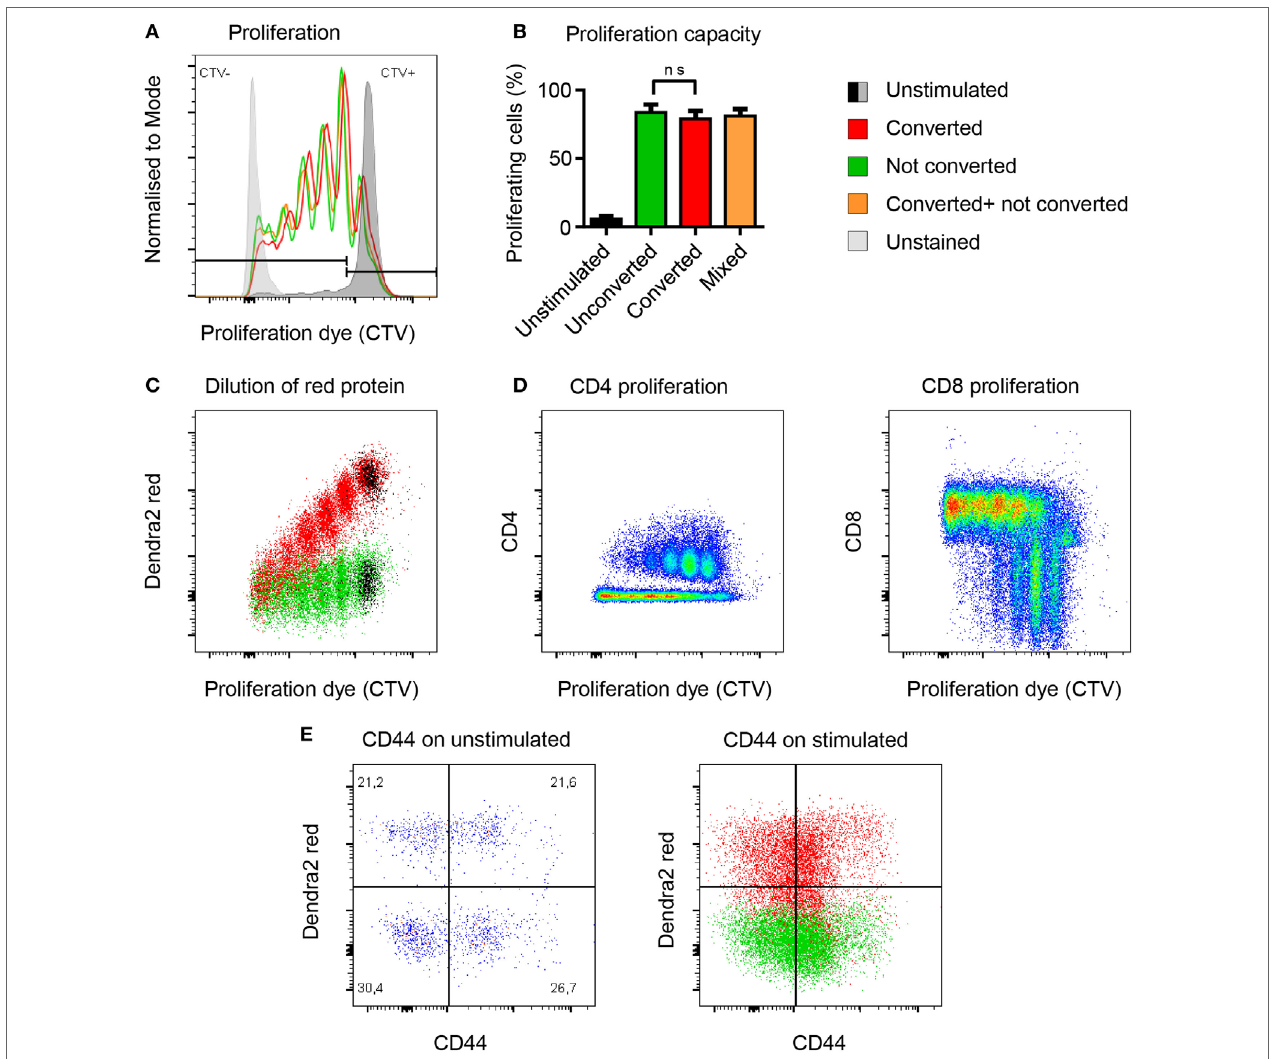
FIGUrE 3 | Photoconversion does not impact the proliferative capacity of Dendra2 + T cells. (A,b) Converted (red), unconverted (green), and mixed (yellow) cells proliferate equally well (non-parametric unpaired test, Mann–Whitney). (c) Flow-cytometric signal of the photoconverted protein plotted against the proliferation dye. Each cell division leads to a 50% reduction of fluorescence intensity of the photoconverted fluorescent protein Dendra2-red. (D) Comparison of CD4 and CD8 cell proliferation upon polyclonal activation of photoconverted Dendra2 + T cells. More rapidly dividing CD8 T cells lose faster their fluorescent cell trace violet (CTV) signal because they proliferate more than the CD4 T cells under this in vitro condition. (E) CD44 expression as a marker of T cell activation before and after stimulation. CD44 levels are comparable in photoconverted cells (red) versus not photoconverted cells (green). All exp: ( n = 3